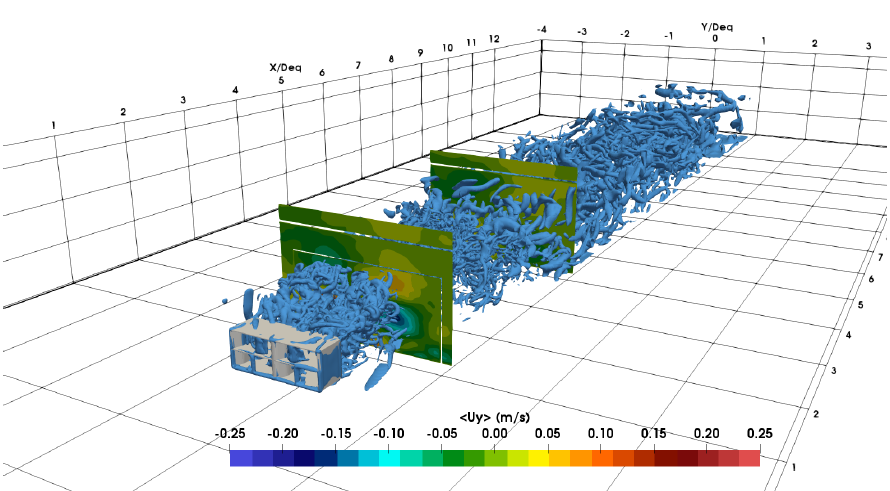
Figure 24. Average < U y > velocity planes at x / D eq = 1.2 and x / D eq = 4.2 in the wake of the turbine for an upstream turbulence rate of I = 12%. Dimensions are scaled by the equivalent diameter D eq = 25.0 m. Vortices are represented with instantaneous iso-contour of the Lambda 2 criterion, Lambda 2 = − 1.0 × 10 − 5 . x and y axis are centered at the turbine